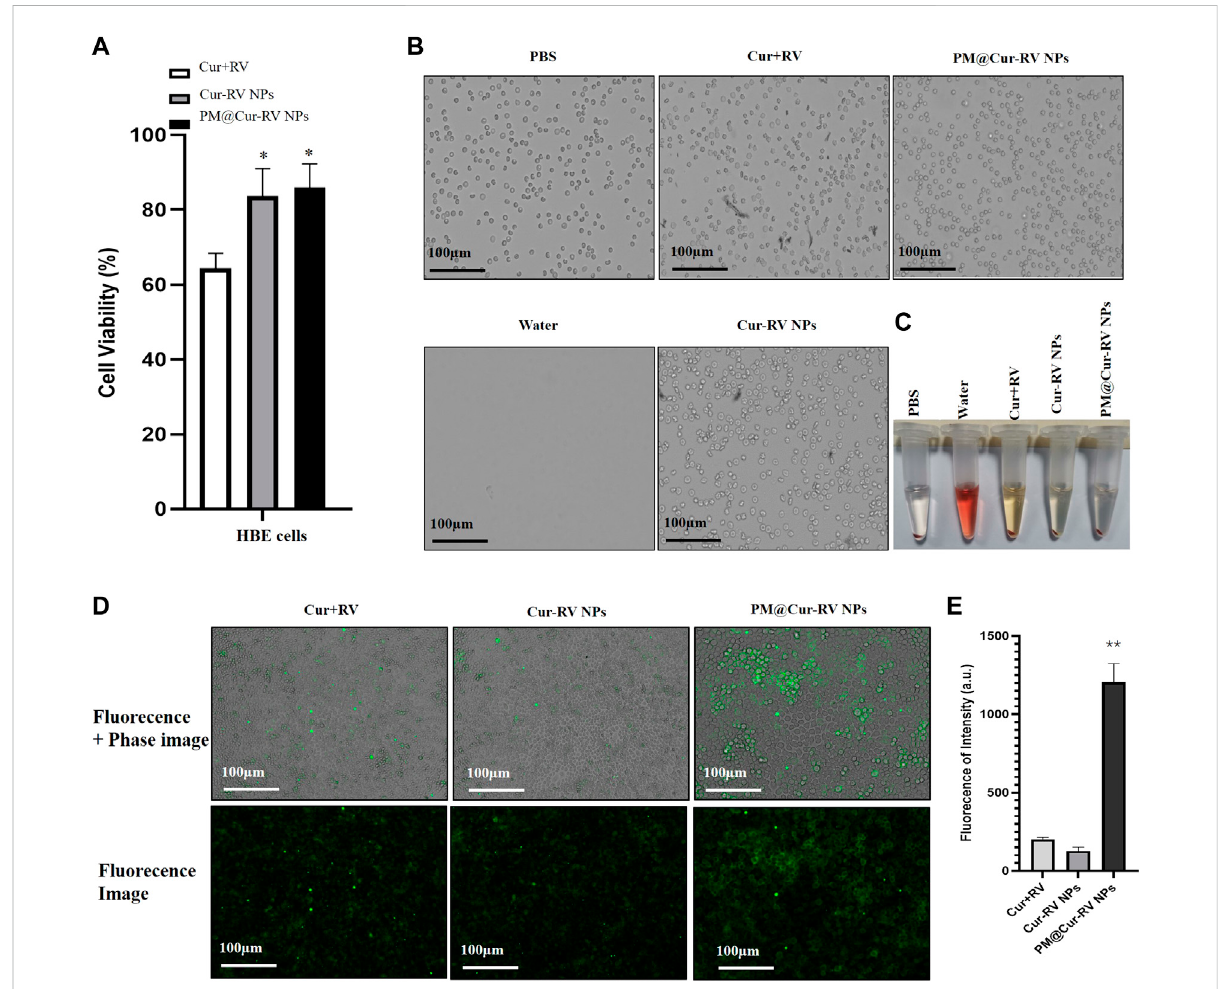
FIGURE 2 Biocompatibilityand biosafety ofdifferentformulations ofCurand RV. (A) Cell viability of human bronchial epithelial cell line (HBEcells)treated withdifferentformulationsofCurandRVat100 μ g/mlfor24 h,whichimpliedthatlowdoseofCurandRVwillnotcausecytotoxicitytocells. (B) The images of hemolysis assay of free Cur and RV, Cur-RV NPs and PM@Cur-RV NPs, separately. (C) The morphology of erythrocytes co-cultured with freeCurandRV,Cur-RVNPs andPM@Cur-RVNPs, separately. (D) Thetypical images ofHBEcell uptakeoffreeCur-RV,Cur-RV-NPsandPM@ Cur-RV NPs (green fl uorescence resulted from Cur). (E) The fl uorescence intensity in HBE cells cocultured with different formulations of